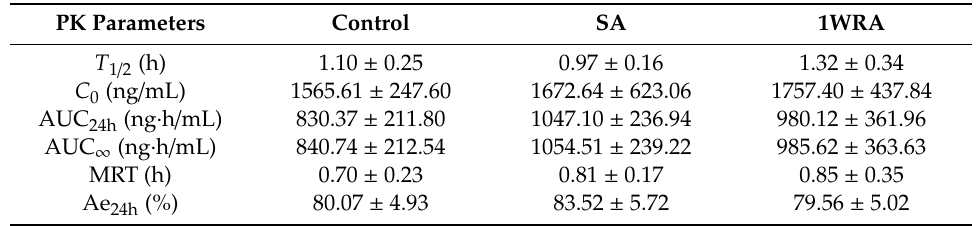
Table 2. Pharmacokinetic parameters of metformin in control, single oral administration (SA), and 1-week repeated administration (1WRA) of RGE (1.5 g / kg / day) following intravenous injection of metformin at a dose of 0.25 mg / kg in rats.